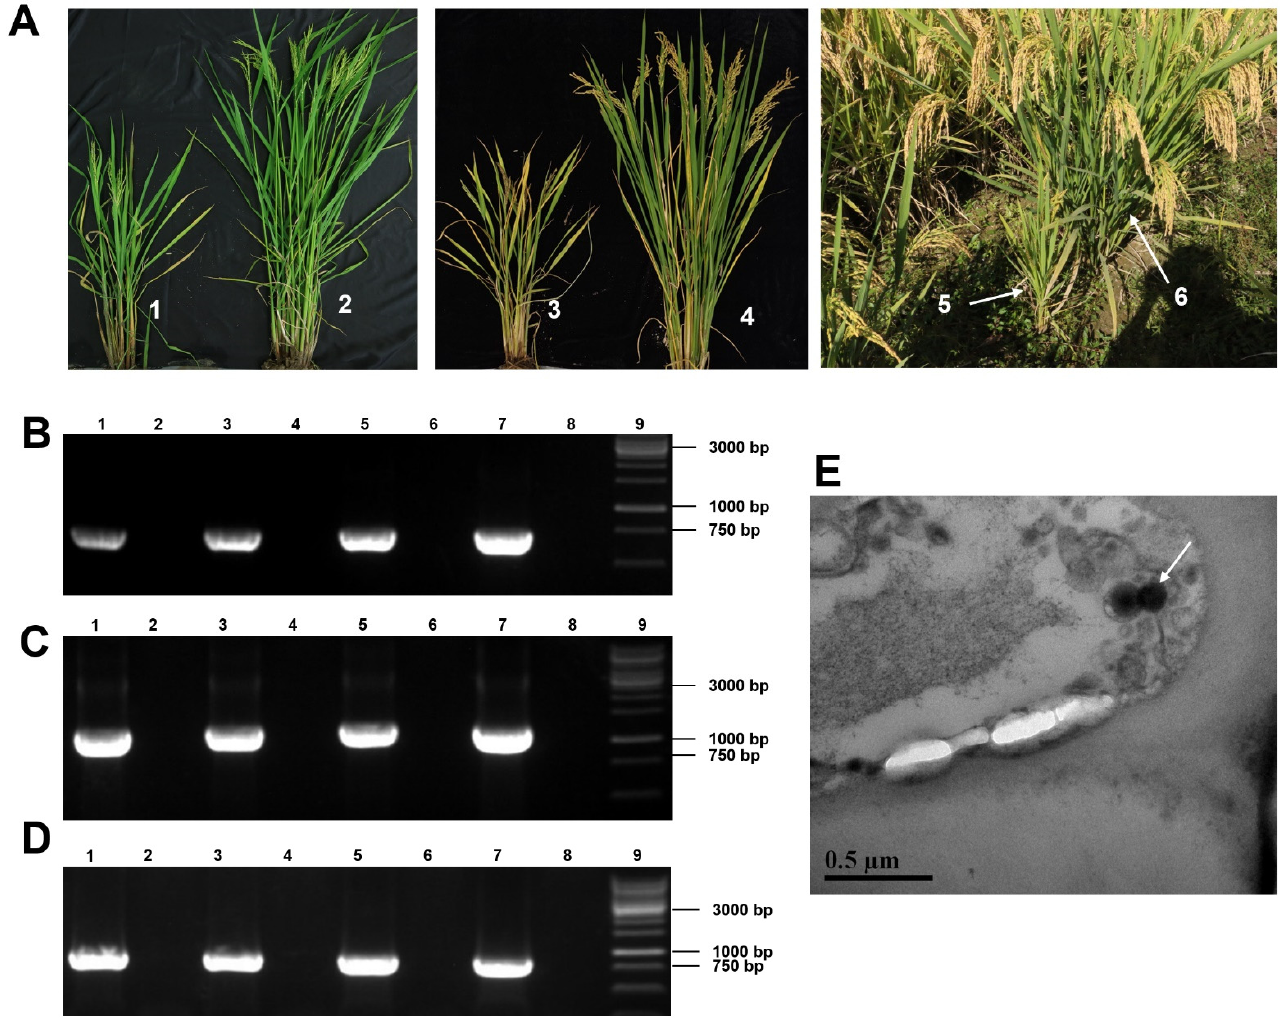
Figure 1. Rice plant symptoms, virions, and RT-PCR detection of the rice dwarf-associated bunya-like virus (RDaBV). ( A ) Field-collected rice plants showed dwarfing symptoms. Nos. 1, 3, and 5 indicate dwarf plants, and Nos. 2, 4, and 6 indicate non-infected plants. ( B – D ) RT-PCR detected RDaBV